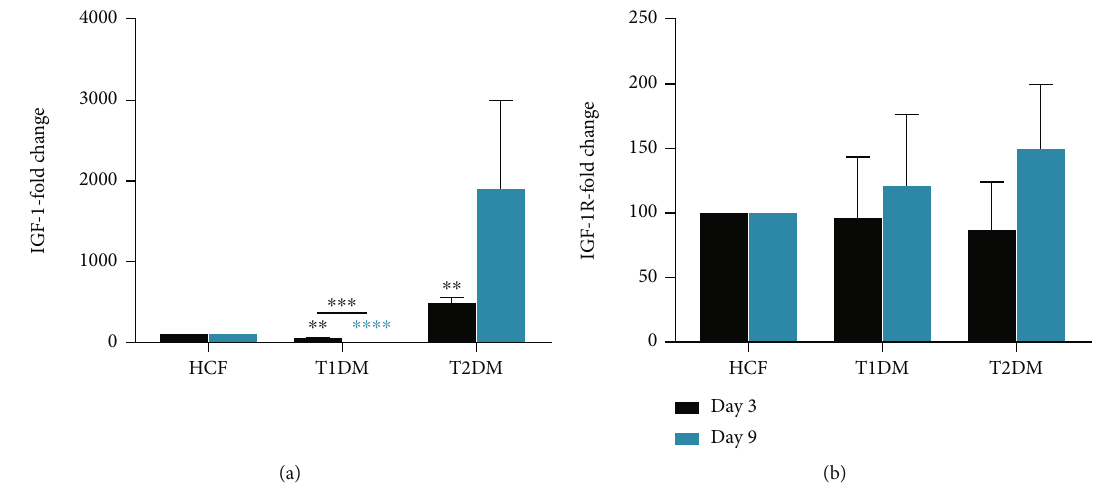
Figure 6: (a) Insulin-like growth factor 1 (IGF-1) and (b) insulin-like growth factor 1 receptor (IGF-1R) protein expression in HCF, T1DM, and T2DM on days 3 and 9. Welch ’ s unpaired t -test ( n = 4 ) was used to analyze the results. Error bars represent the standard deviation ( ∗∗∗∗ denotes p < 0 : 0001 , ∗∗∗ denotes p < 0 : 001 , and ∗∗ denotes p < 0 : 01